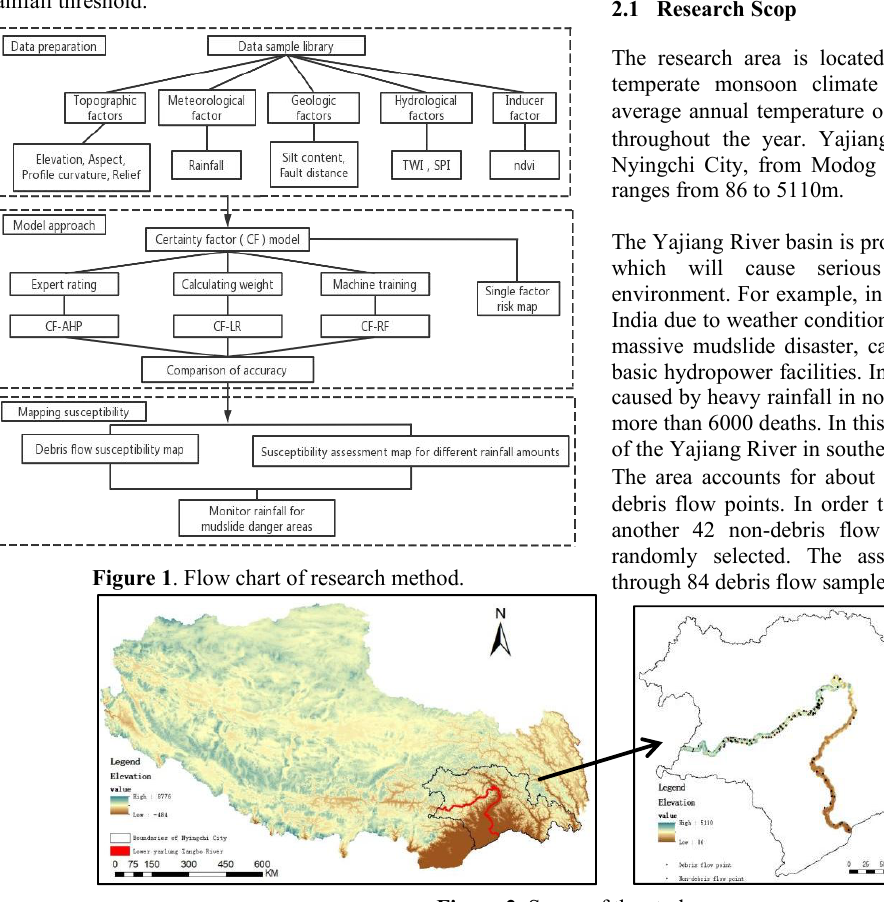
Figure 2 . Scope of the study